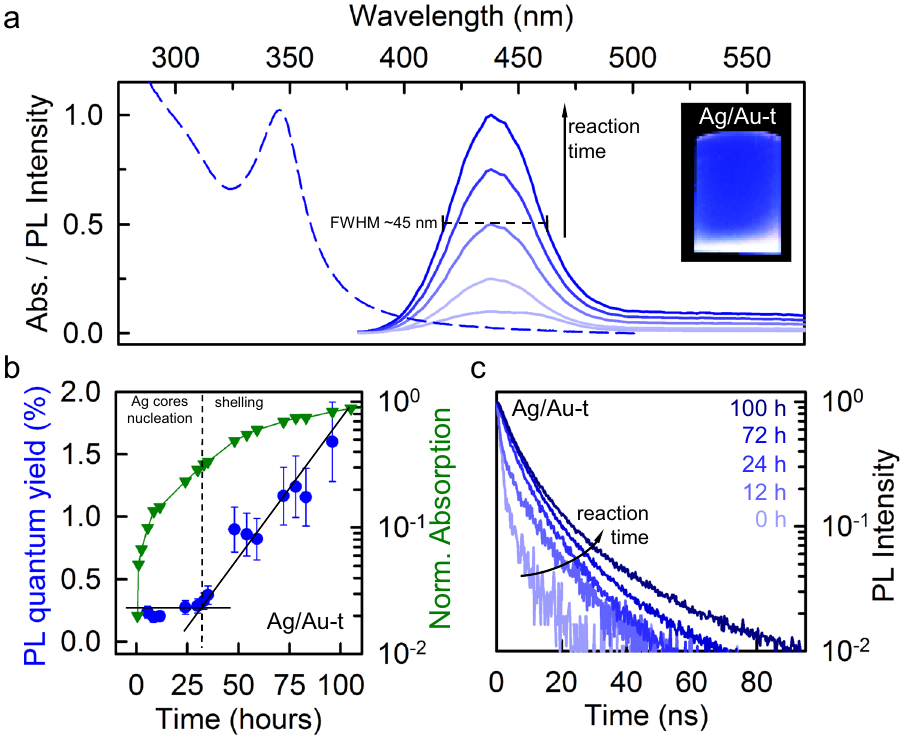
Figure 3. ( a ) Absorption and PL spectrum of protected Ag clusters (Ag/Au-t) dispersion in water. The intensity of the emission increases with the reaction time. The inset is a digital picture of the dispersion under UV lamp excitation. ( b ) PL quantum yield (circles), normalized absorption (triangles) and ( c ) time-resolved PL decay traces at 435 nm as function of the reaction time. All measurements were performed at room temperature using a 355 nm pulsed laser as excitation source, with an excitation fluence of 130 μ J/cm 2